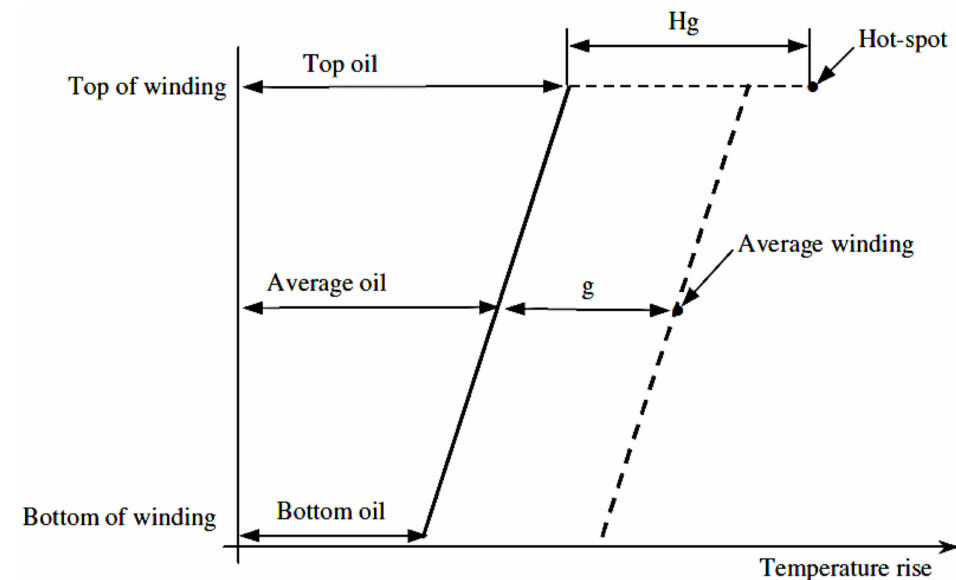
Figure 3. Transformer thermal